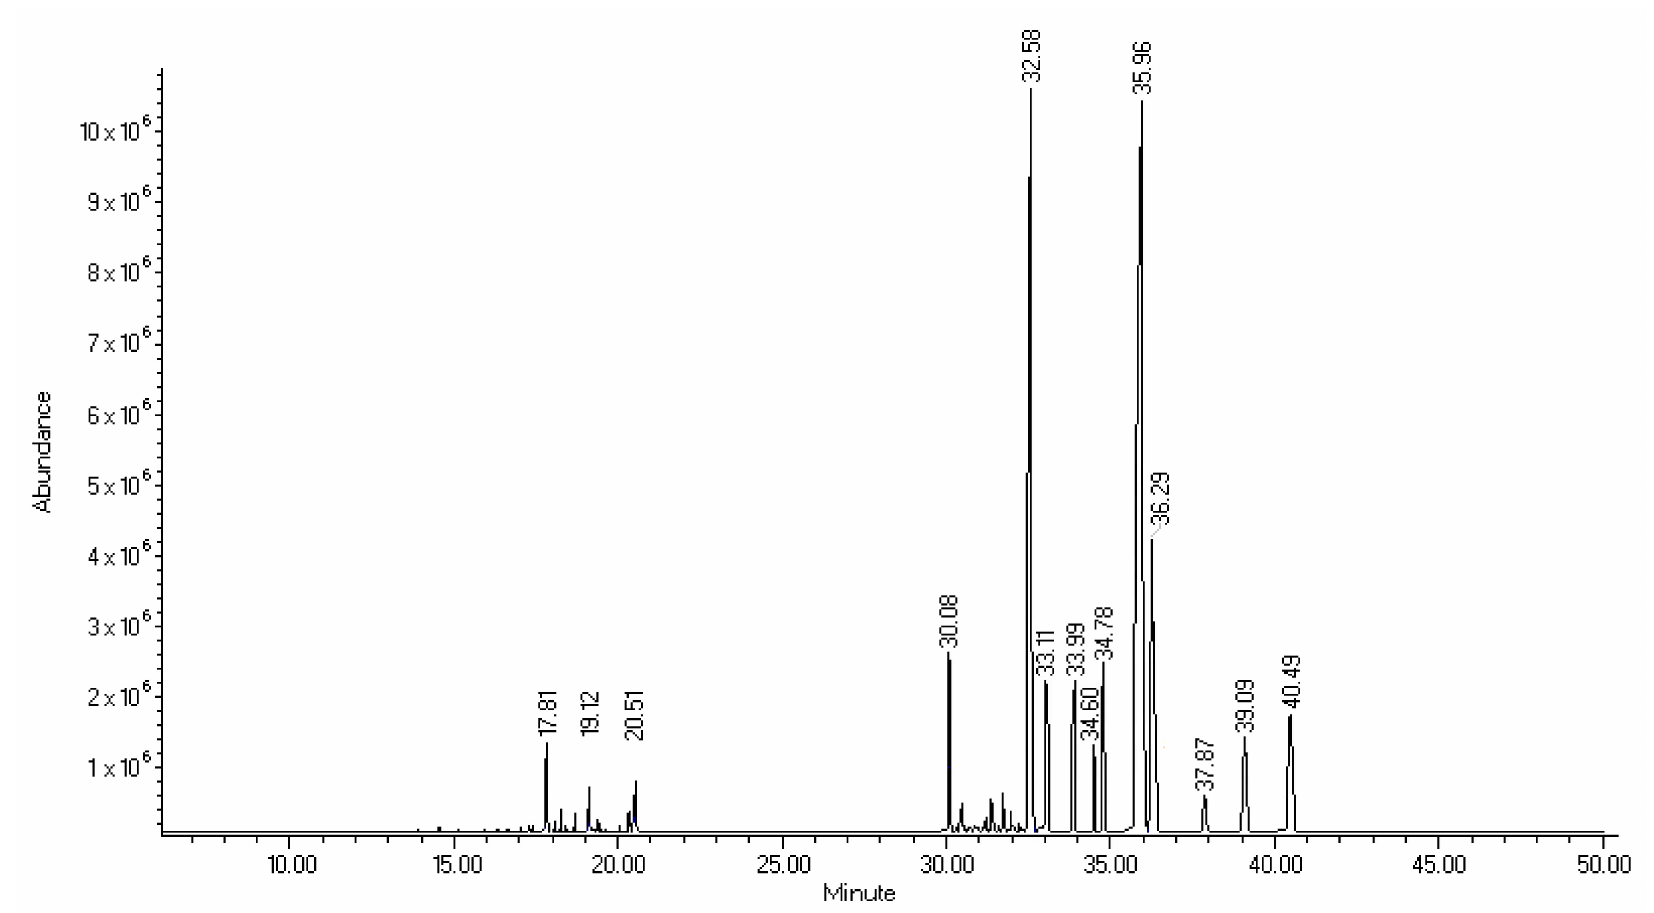
Figure 1. Mass spectrum of DME compounds analyzed by GC-MS. β -Sitosterol (36.29 min), α -tocopherol (33.11 min), α -amiryn (37.87 min), methyl octacosanoate (32.58 min), and in a lower percentage: phytol (17.81), gedunin (30.08 min), hexacosanol (31.85 min), octacosanoic acid methyl ester (33.99 min), α -tocopherol (33.11 min), ciclooctacosane (34.78 min), α -amyrin (37.87 min), and 1-Dotriacontanol (33.99